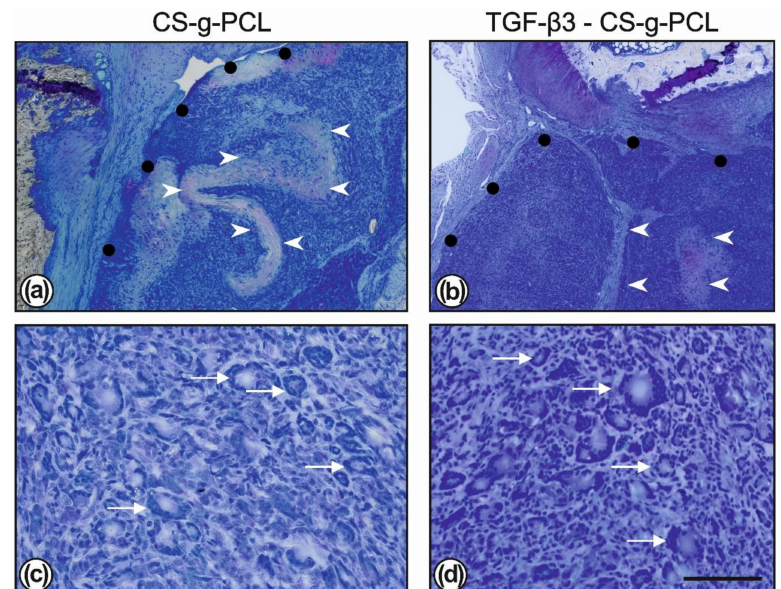
Figure 4. Toluidine blue staining showed the degradation of the CS–g–PCL scaffolds (outlined with black dots; ( a , c )) and the TGF– β 3–CS–g–PCL fibre scaffolds (outlined with black dots; ( b , d )). The scaffolds are infiltrated with numerous cells; only a few areas with a denser fibrous structure are less infiltrated (marked by white arrowheads). At higher magnification the normal immune reaction is also indicated by the presence of numerous multinucleated foreign body giant cells (marked by white stars; c and d) which eliminate the degradation products of the scaffolds. Bar = 400 µ m ( a , c ); 50 µ m ( c , d